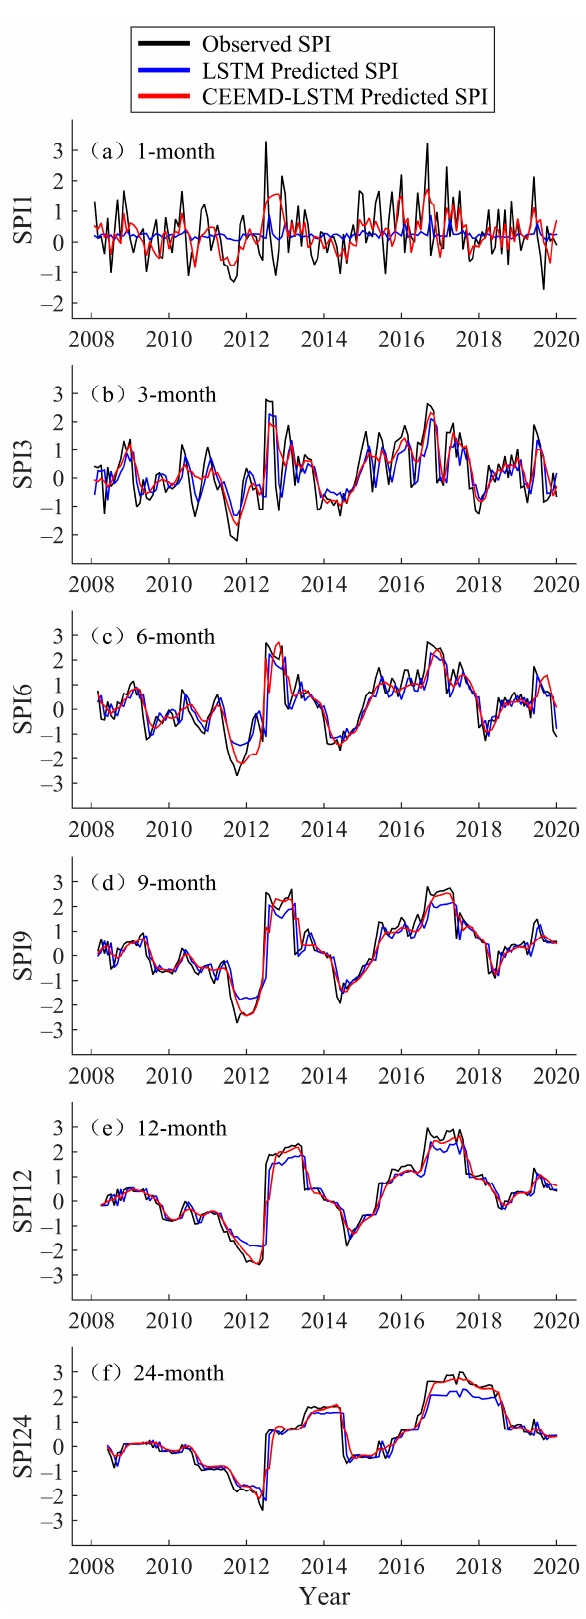
Figure 6. Forecast of multi-timescale SPI values of the LSTM and CEEMD-LSTM model at Kuerle Station (2008–2019).